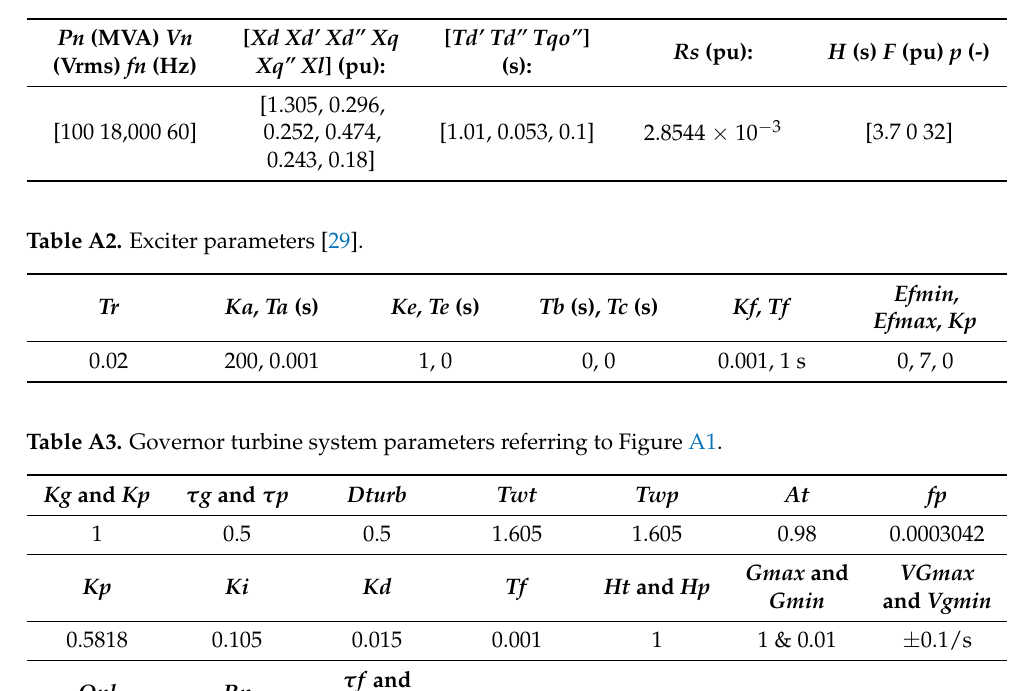
Table A1. Synchronous machine parameters [28].